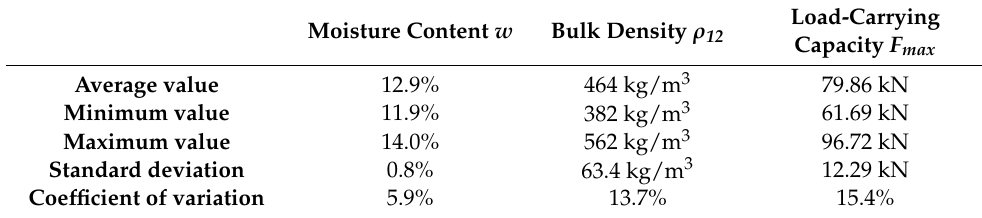
Figure 11. Load-deformation curves of H1 specimens.